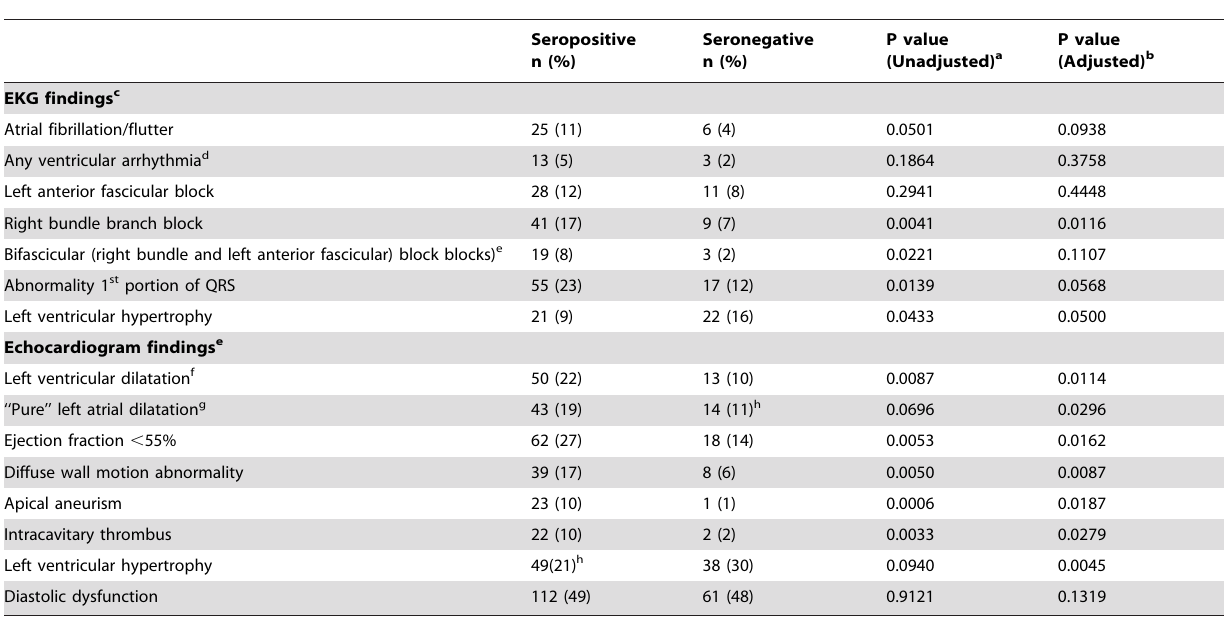
Table 2. EKG and echocardiogram findings among patients with and without Trypanosoma cruzi infection.